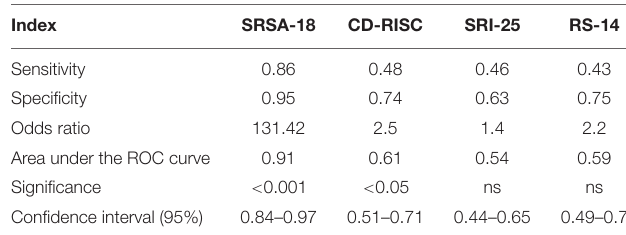
TABLE 7 | Efficiency in the prediction of each